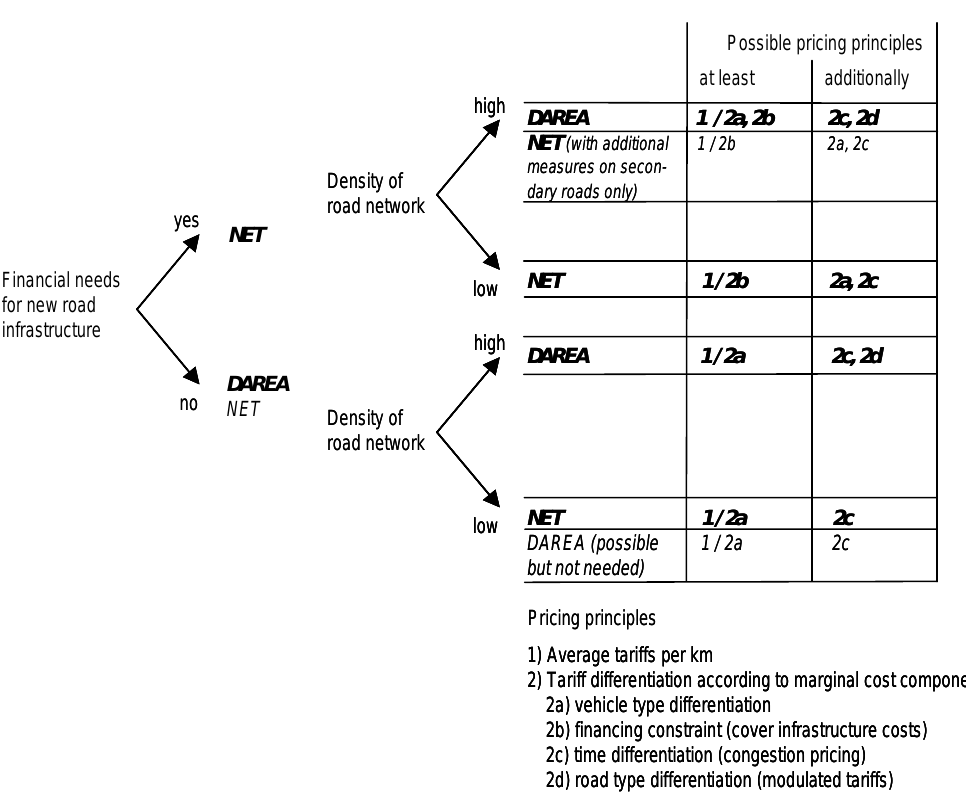
Figure 1. Decision tree to derive basic form of